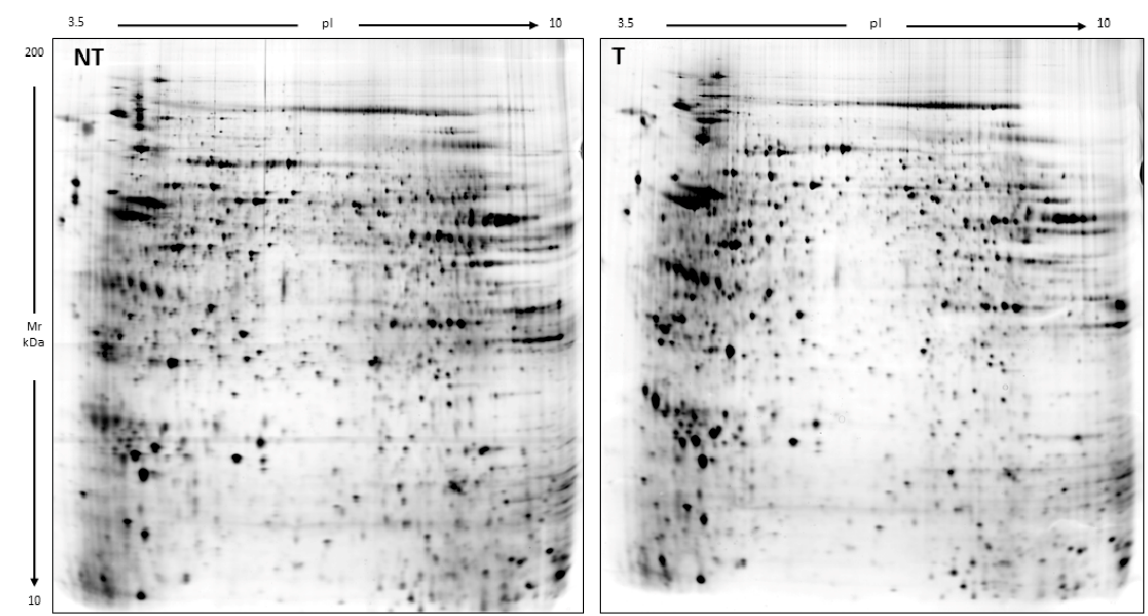
Figure 3. Master gels obtained by two-dimensional electrophoresis that are representative of the untreated and post-treated (NT and Post-T) sample groups. Two dimensional electrophoresis (2DE) maps show protein spots with an isoelectric point from pH 3 to pH 10 and a molecular weight from 10 to 200 kDa.